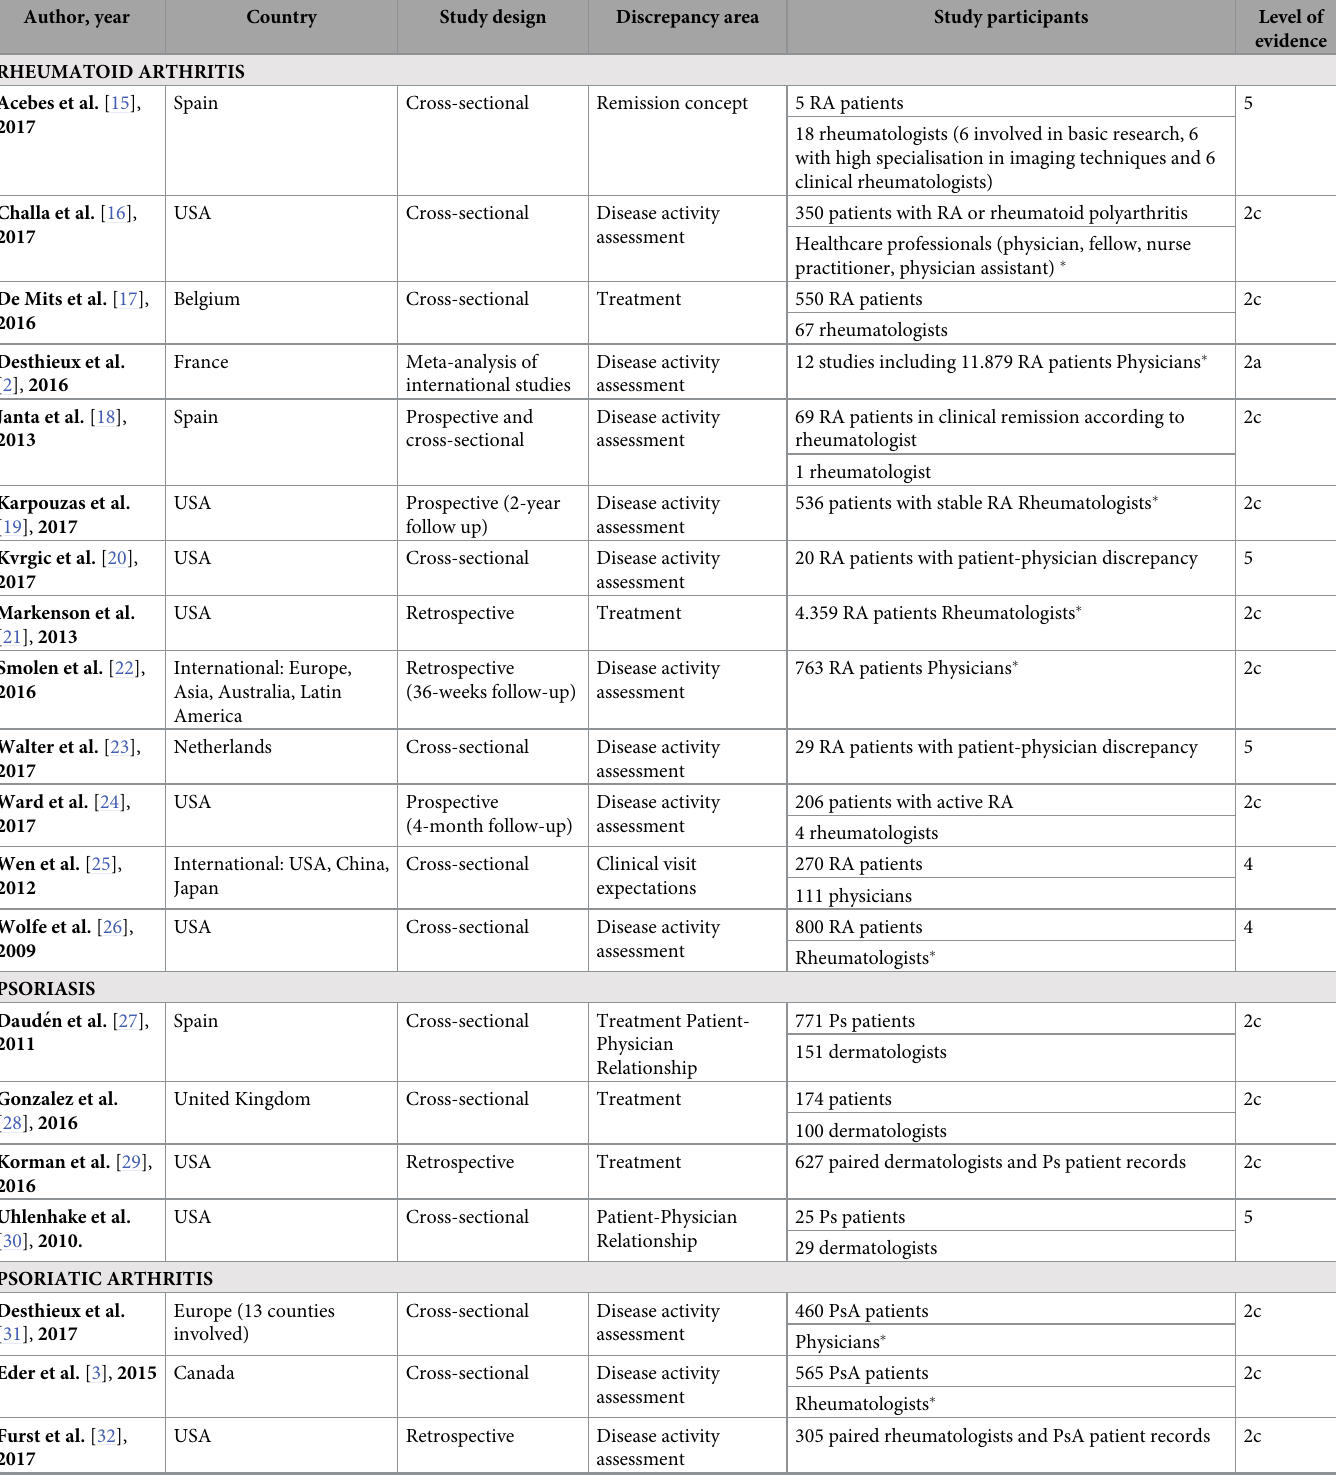
Table 1. Characteristics of the 21 studies included in the systematic